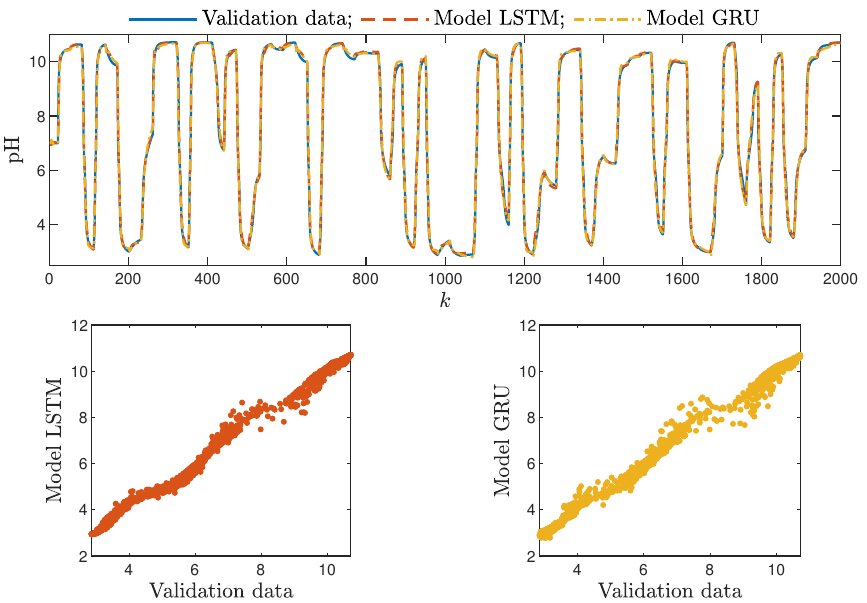
Figure 13. The neutralisation reactor: the validation dataset vs. the output of the LSTM and GRU models for n N = 8, n A = 0, n B =